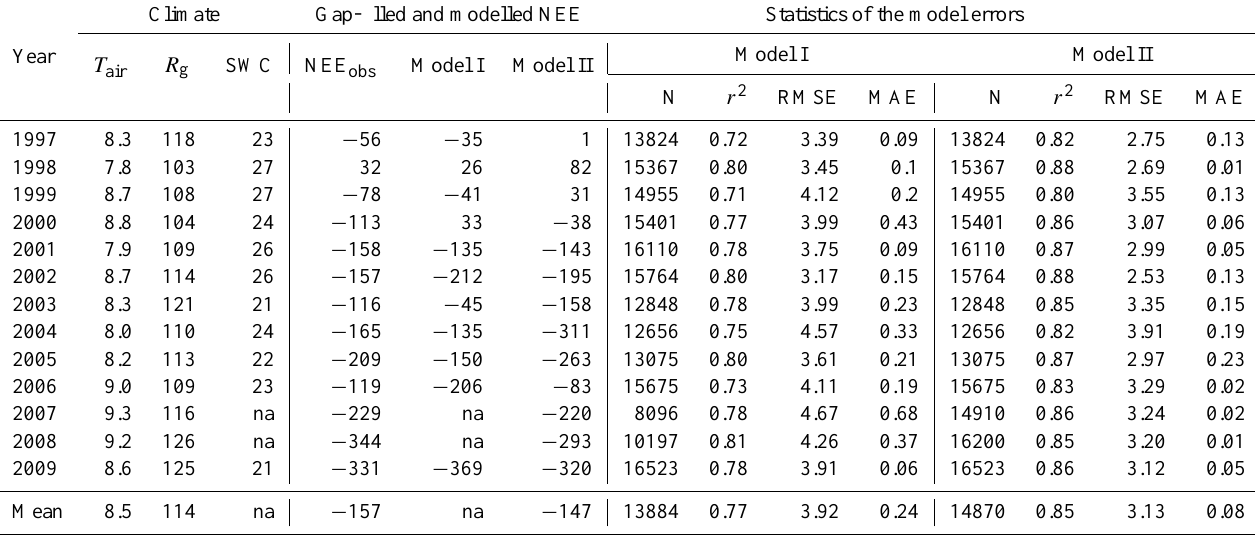
Table 1. Mean annual climate variables, gap-filled and modelled NEE and model error statistics for the two semi-empirical models of forest- atmosphere CO 2 exchange. Model I is the model from Richardson et al. (2007) and Model II is the model from Lasslop et al. (2010b). The statistics of the model errors were based on non-gap filled